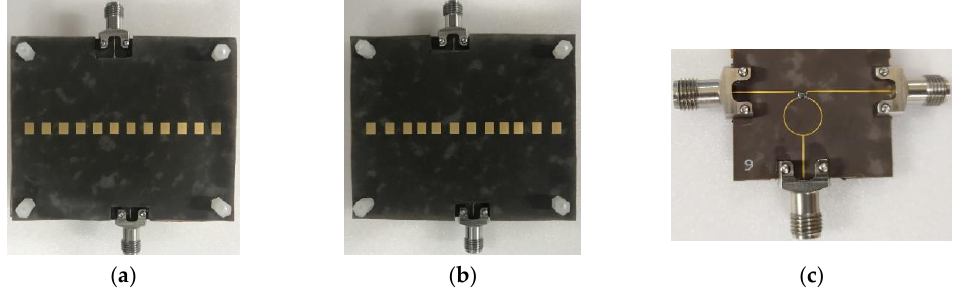
Figure 11. ( a ) Fabricated non-uniformly powered and uniformly spaced antenna array with parasitic patches. ( b ) Fabricated non-uniformly powered and spaced antenna array with parasitic patches. ( c ) Wilkinson power divider for two output ports with 180 ◦ phase shift.